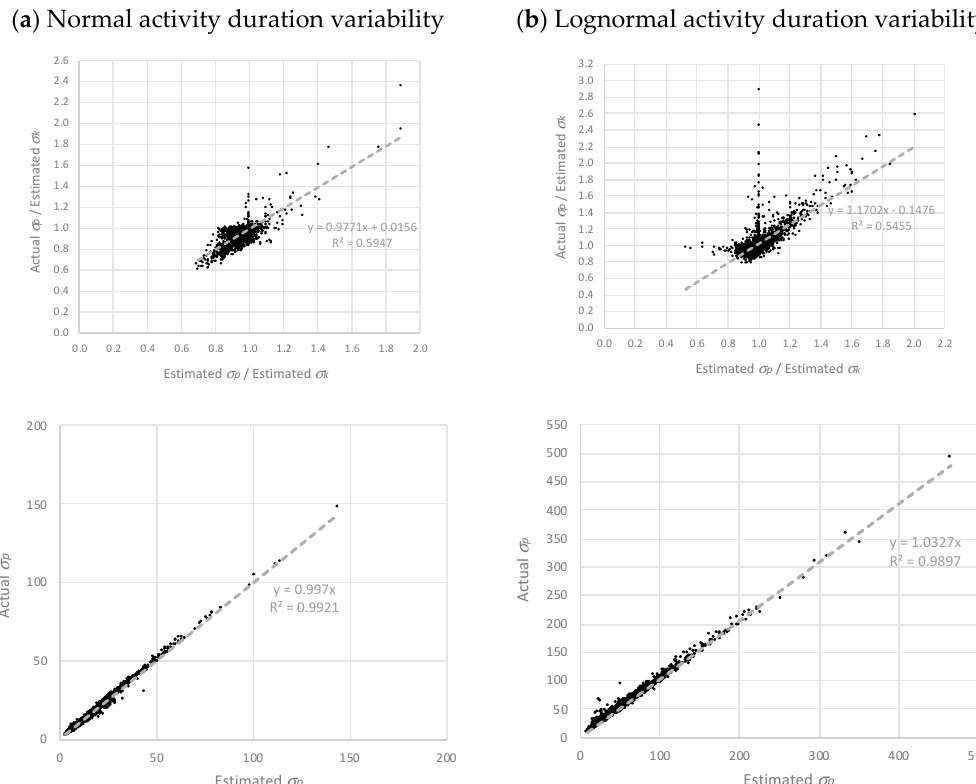
Figure 3. Dataset I σ p regressions with normal ( a ) and lognormal ( b ) activity duration variability.